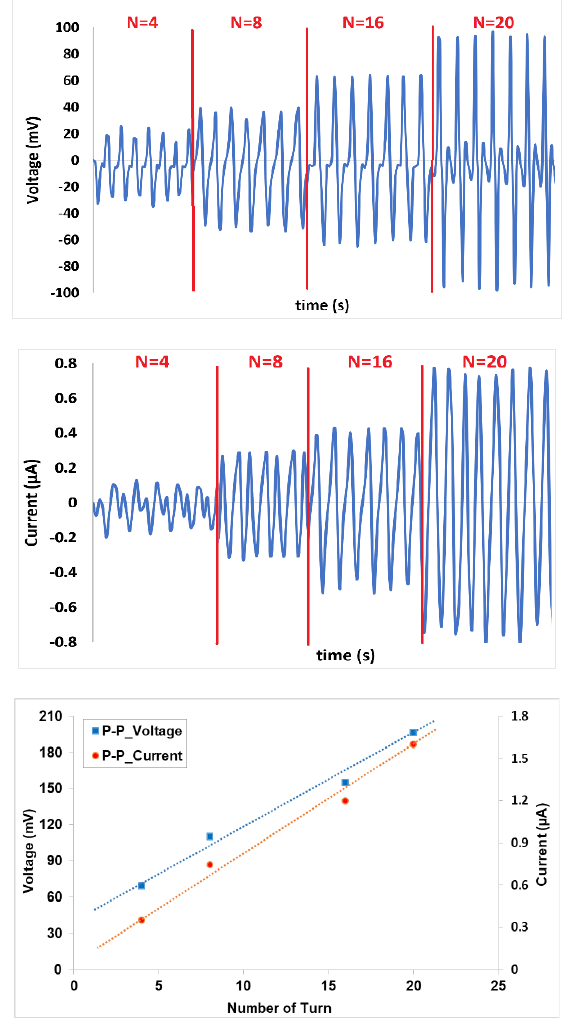
Figure 4. Measured parameters for the spiral electrode TENG with different turn numbers; a) output voltages, b) output currents, c) compared values for output voltages and currents vs. several